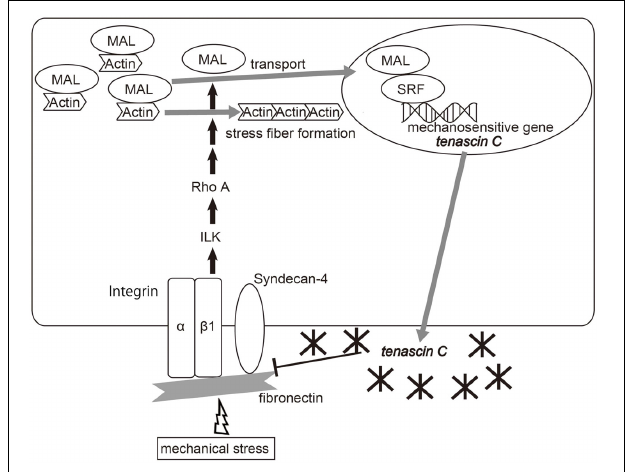
FIGURE 1 | Diagram of the molecular pathway of the mechano-induction of tenascin-C. Mechanical strain activates RhoA in fibroblasts, depending on fibronectin, integrin β 1 and integrin-linked kinase (ILK), which causes the reduction of monomeric G-actin by inducing actin assembly and stress fiber formation. Depletion of the G-actin pool frees MAL/myocardin-related transcription factor-A (MRTF-A)/megakaryoblastic leukemia-1 (MKL1) to enter the nucleus, which induces TNC expression partly depending on serum response factor (SRF). Meanwhile, TNC binds fibronectin at the syndecan-4 binding sites and interferes with fibronectin-mediated RhoA activation, and finally suppresses TNC transcription. Adapted from Asparuhova et al. (2009), Imanaka-Yoshida et al. (in